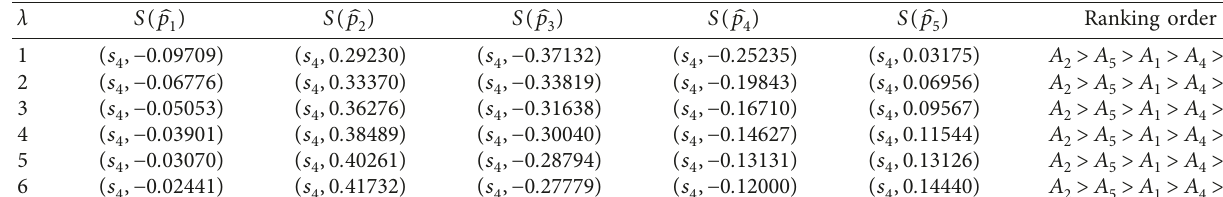
Table 9: Score values by varying λ based on the 2 TL m FHWG operator.